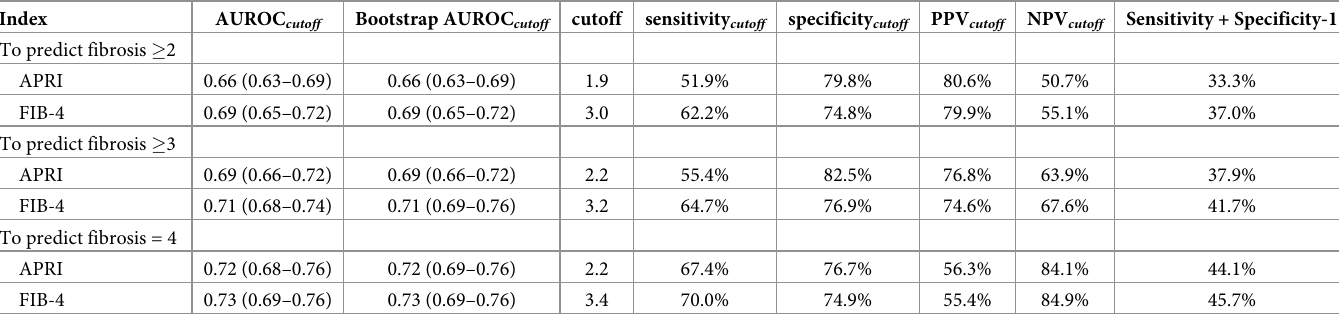
Table 5. Diagnostic accuracies of APRI and FIB-4 for predicting liver fibrosis (74 < AST (cid:20) 148 IU/L, N = 737). Index AUROC cutoff